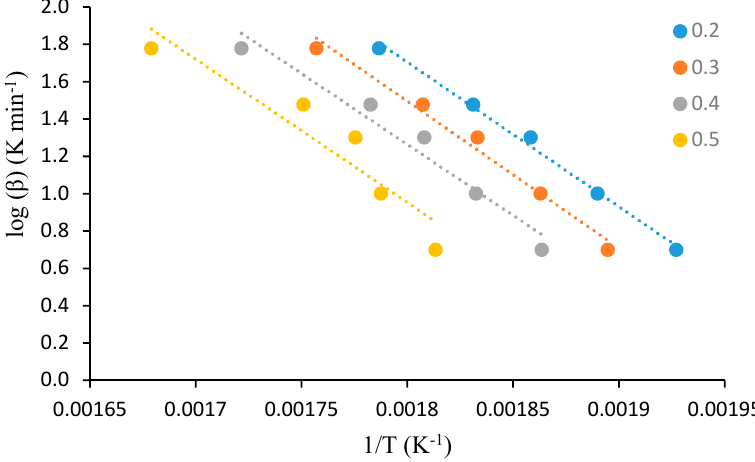
Figure 5. A plot of log β vs. 1/ T at various α values (given as the inset) for agar-agar.